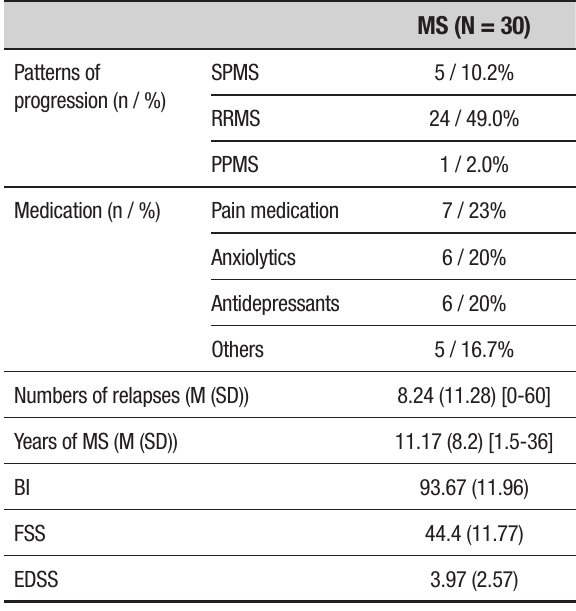
Table 1. Clinical characteristics of the MS group.